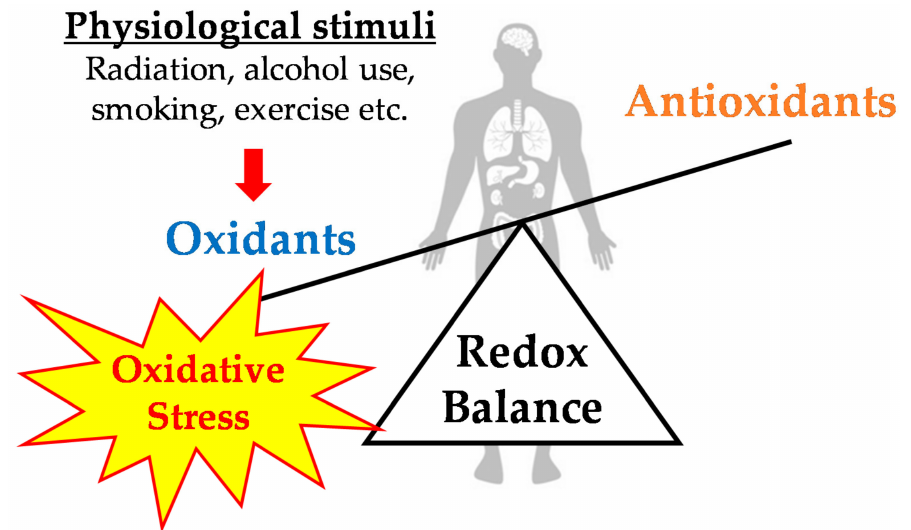
Figure 1. Redox balance and oxidative stress in living